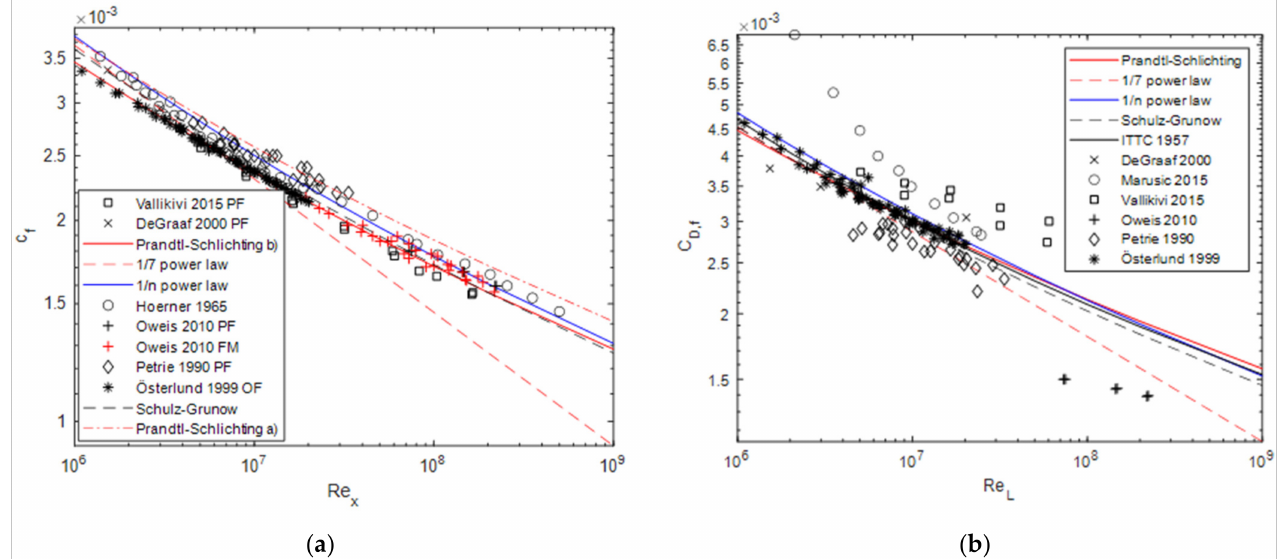
Figure 5. ( a ) Local friction coefficient compared to experimental data (as above, but additionally from Hoerner [18]) and the Prandtl–Schlichting formula, as well as the formula given by Schulz– (cid:0) (cid:1) − 2.584 Re x Grunow c f = 0.37 · log [19], PF = profile fit, FM = force measurement, OF = oil-film 10 measurement; ( b ) Friction drag coefficient calculated by C D , f = 2 θ (cid:0) − (cid:1) − 2.64 Re x 0.407 + log according to [19], C D , f = 0.455 · 10 (cid:0) (cid:1) − 2 C D , f = 0.075 · Re x − 2 log according to 10